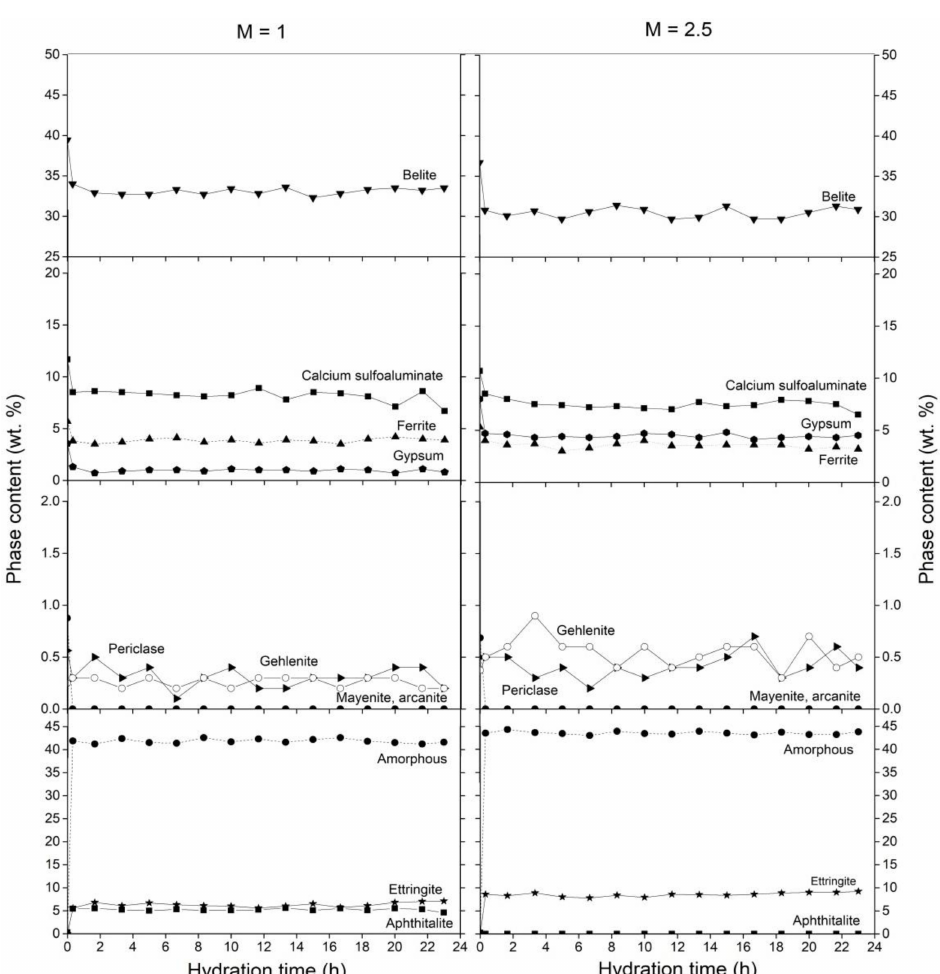
Figure 7. Phase content of clinker phases and hydrates in the cement pastes with M = 1 and M = 2.5 cured at 60 ◦ C during first 24 h of hydration.